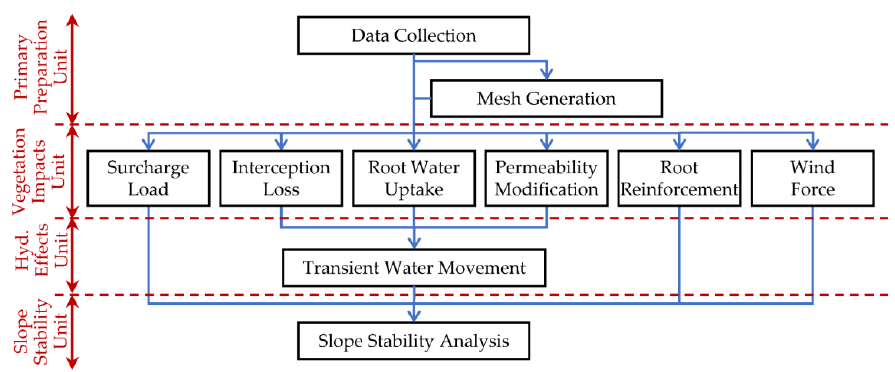
Figure 2. Flowchart of the developed model.